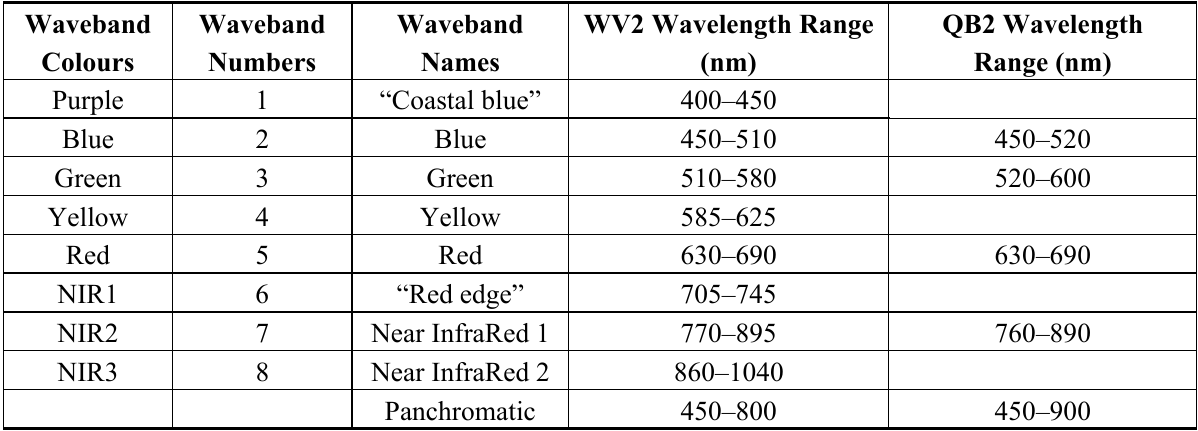
Table 1. Spectral characteristics of the two best Very High Resolution spaceborne sensors, Worldview-2 (WV2) and QuickBird-2